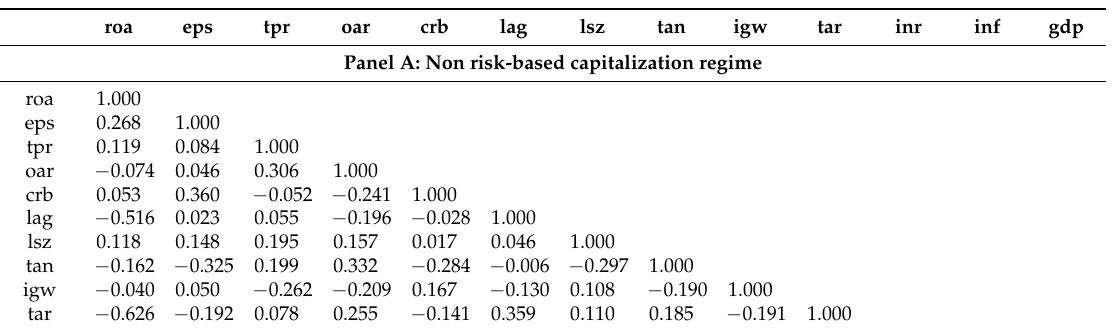
Table 3. Simple correlation matrix of research variables between 1995–2002 and 2008–2015. roa eps roa gdp Panel A: Non risk-based capitalization